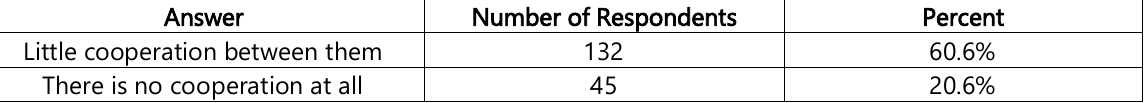
Table 7: Reflection of the Perception that the cooperation Between the State and Citizens against Fiscal Evasion (Source: Authors’